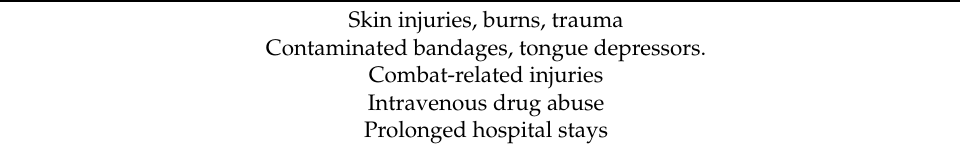
Table 2. Factors increasing mucormycosis vulnerability in immunocompetent individuals. Skin injuries, burns, trauma Contaminated bandages, tongue